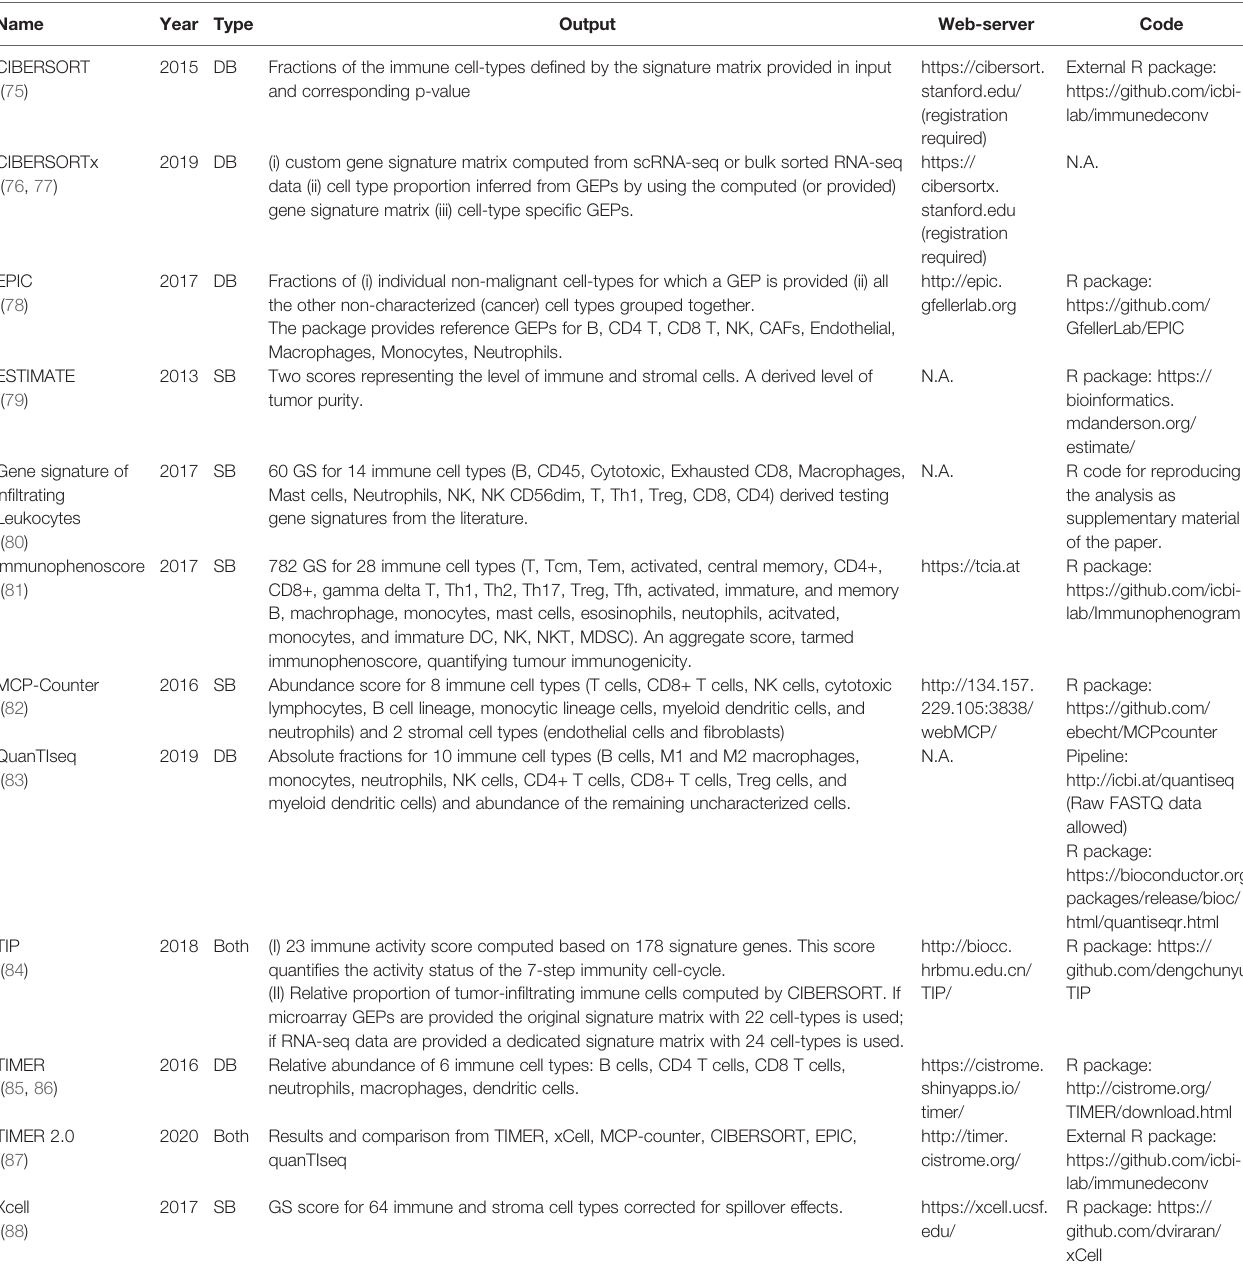
TABLE 1 | Current state-of-art computational